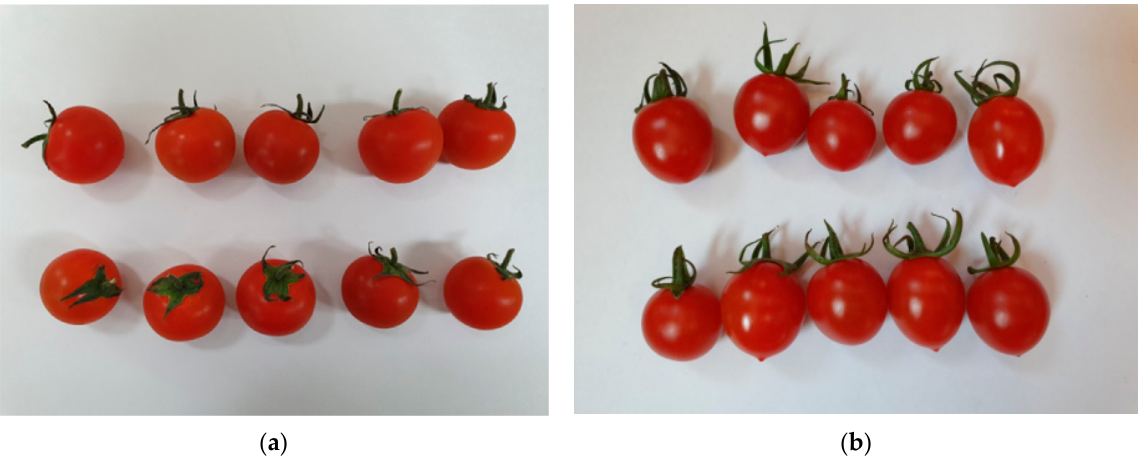
Figure 2. Cherry tomatoes used in performance tests: ( a ) circular-shaped cherry tomato (Icon513) ( b ) jujube-shaped cherry tomato (Minimaru).